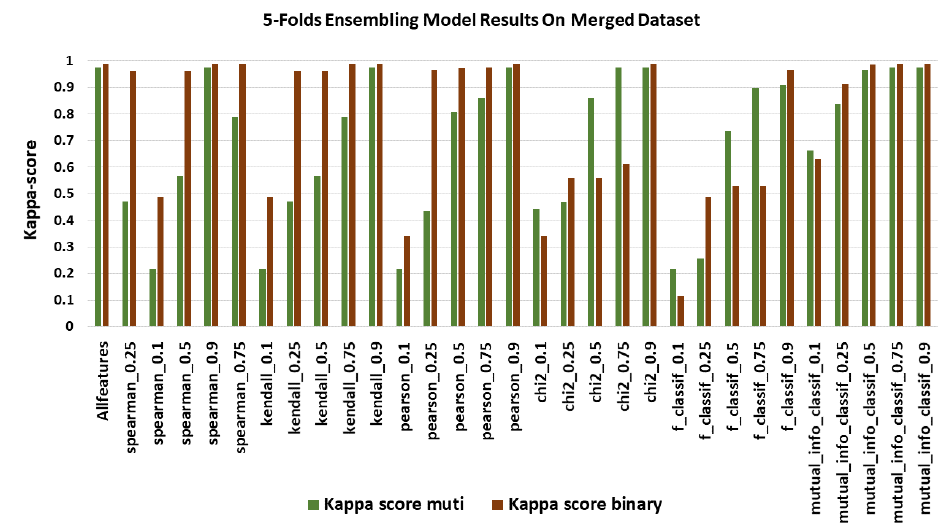
Figure 8. Kappa scores using merged dataset.